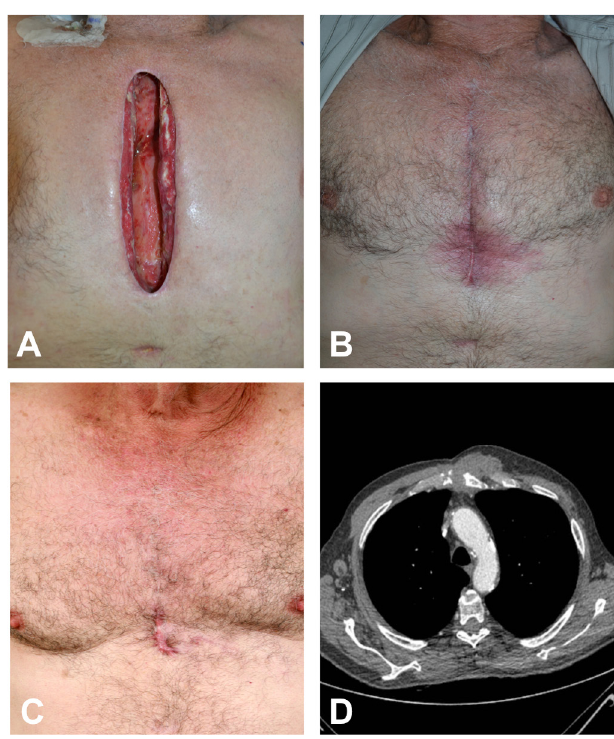
Fig. 3 - A 67-year-old man with sternal wound dehiscence due to mediastinitis after valve replacement surgery underwent reconstruction using the left pectoralis major muscle flap. (A) Sternal wound dehiscence. (B) Hyperemia of the lower scar due to subcutaneous granuloma three months surgery. (C) Three-month postoperative period after correction of the granuloma using local rhomboid flap. (D) Computed tomography six months after surgery.